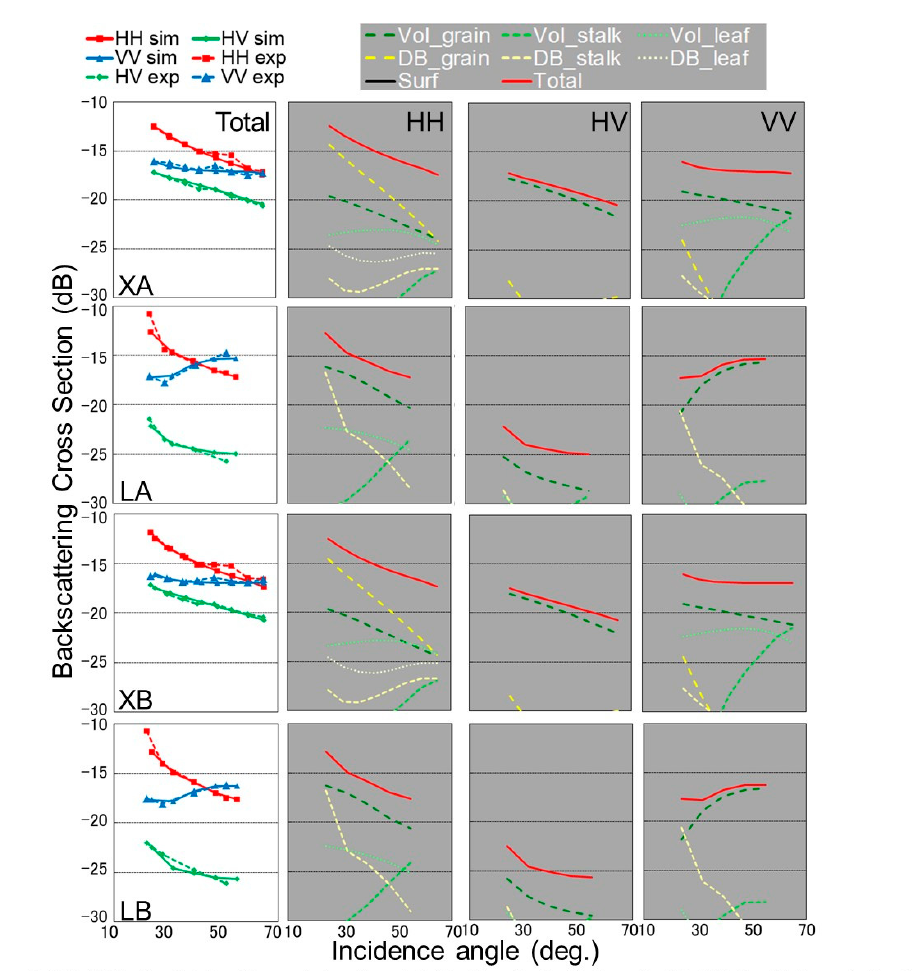
Figure 13. Comparison of the experimental data and DSM simulation results on blocks A and B at the X- and L-bands (left). Contribution of each scattering mechanism is also shown on the right-hand side with respect to polarization